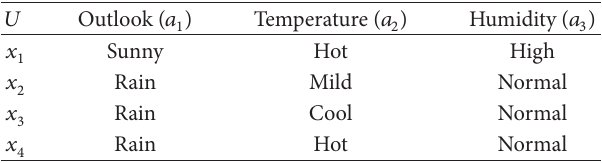
Table 1: An information